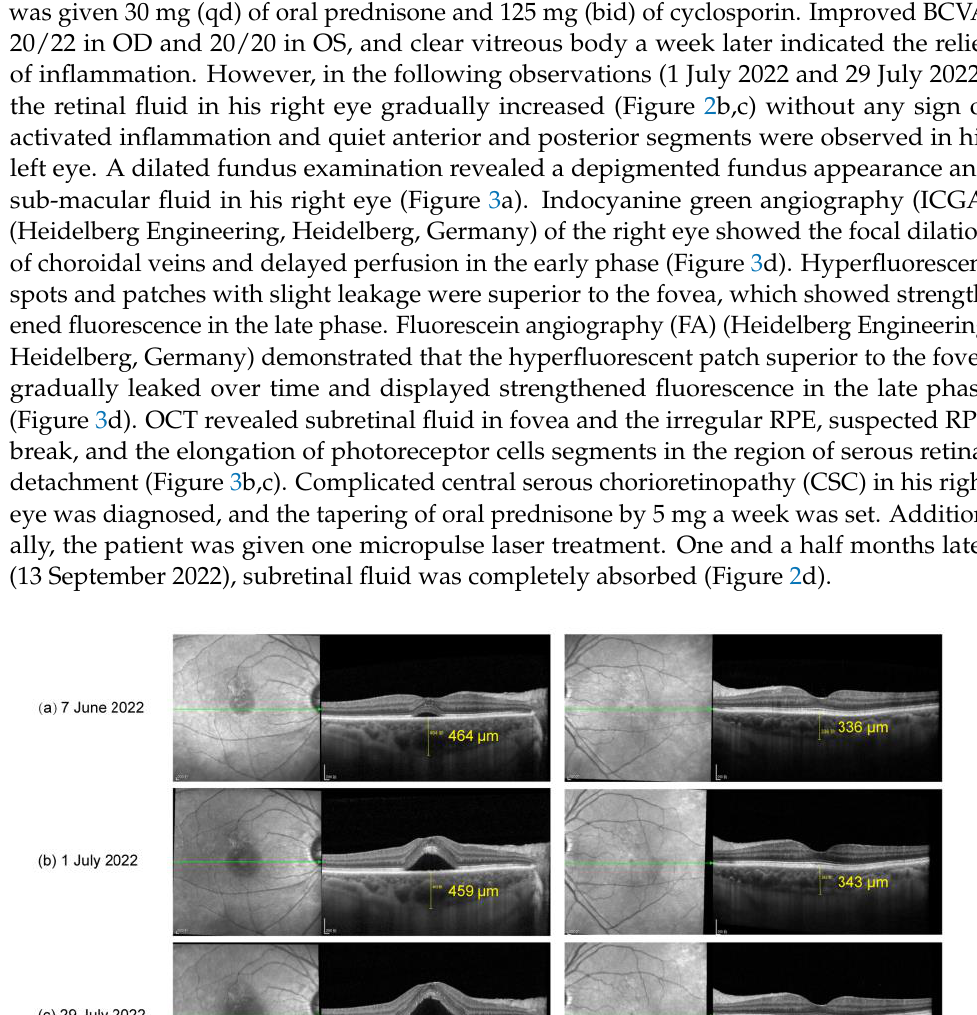
Figure 2. ( a ) OCT on 7 June 2022: sub-macular fluid OD and increase in choroid thickness OU; ( b ) OCT on 1 July 2022 and ( c ) OCT on 29 July 2022: significantly increased sub-macular fluid OD; ( d ) OCT on 13 September 2022: completely absorbed subretinal